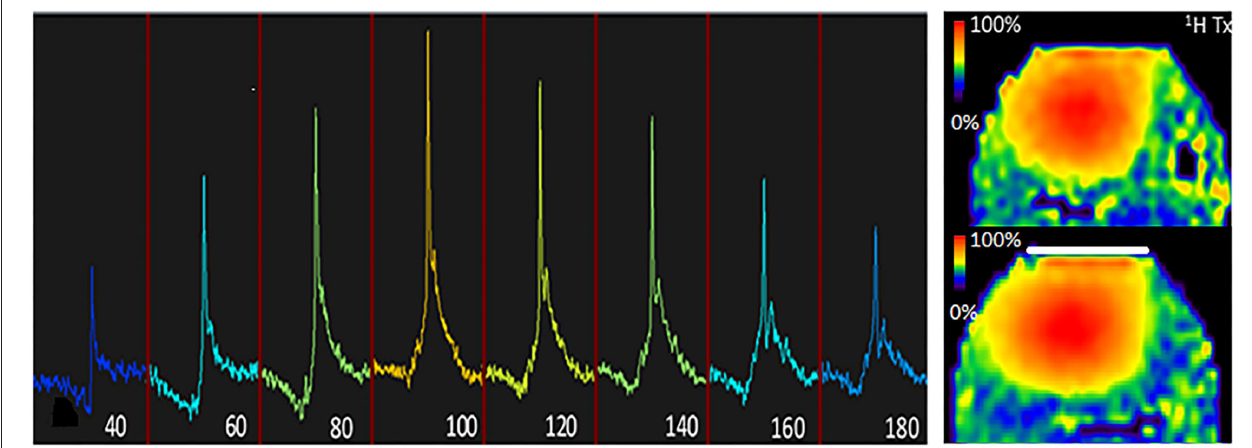
30s when using the 31 P =